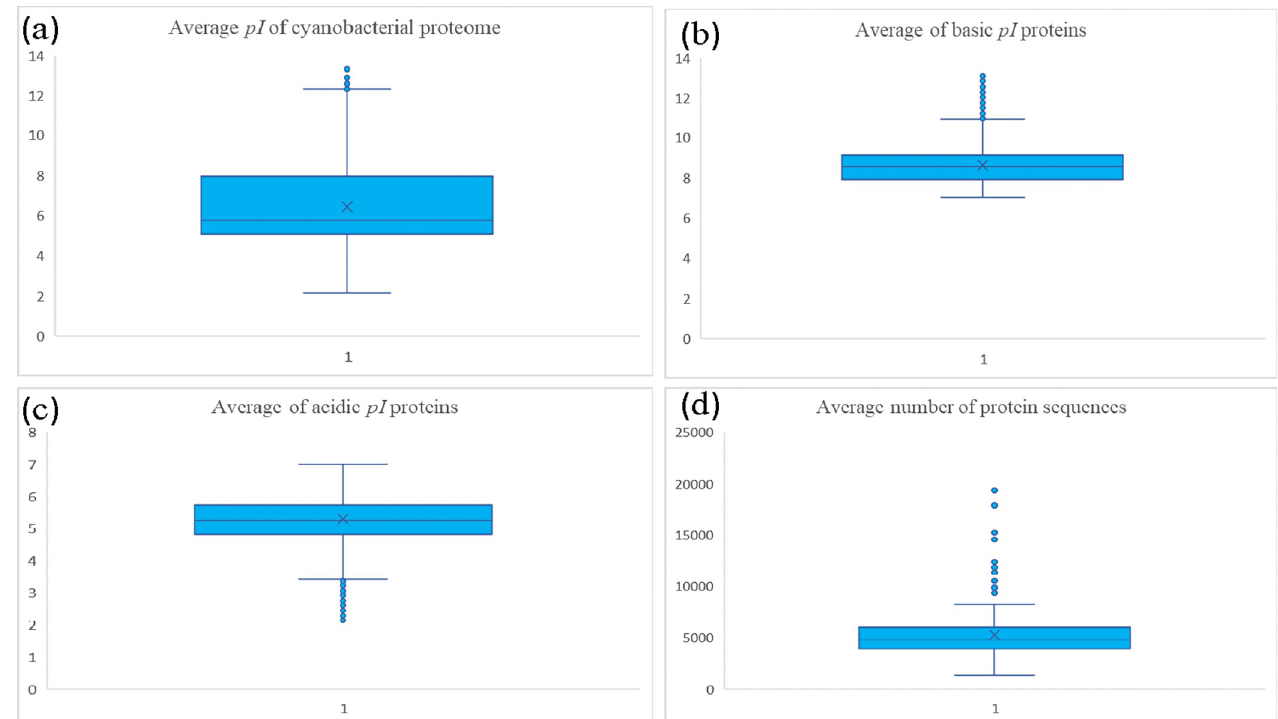
Fig 1. Box and whisker plot of (a) average pI of cyanobacterial proteins (b) average of basic pI proteins (c) average of acidic pI proteins and (d) number of protein sequences of cyanobacterial proteomes used in this study. The graphs were prepared using Microsoft excel version 2016. Table). The average molecular weight of the cyanobacterial proteome was 182173.1324 kDa. Calothrix desertica was also encoded the highest number of protein sequences (19335), while Candidatus synechococcus spongiarum encoded the lowest (1337). Overall, cyanobacterial spe- cies encoded an average of 5260.704 protein sequences (Fig 1). The species, Anabaena cylin- drica , was found to only encode 17878 protein sequences, and the molecular weight of the proteome of this species was 207570.656 kDa. These data indicate that the number of protein sequences in the proteome is not directly proportional to the molecular weight of the prote- ome. The proteome of the cyanobacterial species from order Spirulinales is comparatively heavier than the proteome of others (S1 Table). The average molecular weight of the protein of different classes of cyanobacteria increasing order was unclassified (30.519 kDa), Synechococ- cales (33.063 kDa), Chroococcidiopsidales (34.311 kDa), Chroococcales (34.487 kDa), Gloeo- bacterales (34.72 kDa), Pleurocapsales (35.571 kDa), Nostocales (35.788), Melainabacteria (36.659 kDa), Oscillatoriales (36.701 kDa), and Spirulinales (37.151 kDa) (S1 File). The molec- ular weight of proteins from Chroococcidiopsidales, Chroococcales, and Gloeobacterales falls around 34 kDa, whereas the molecular weight of proteins from other groups is slightly differ- ent. To further corroborate this premise, a correlation regression analysis was conducted based on the number of protein sequences and the molecular weight of the proteome. Results indicated that the number of protein sequences of the cyanobacterial proteome is only slightly proportional to the molecular weight of the proteome (kDa) (S1 Fig). Although the correlation was positive ( r = 0.918, y = 13570 + 32.07 x), it was < 1 (S1 Fig). The D’Agostino and Pearson omnibus normality test indicated that the cyanobacterial proteome did not come from a nor- mally distributed population (it did not pass the normality test at α = 0.05, p � 0.0001). One